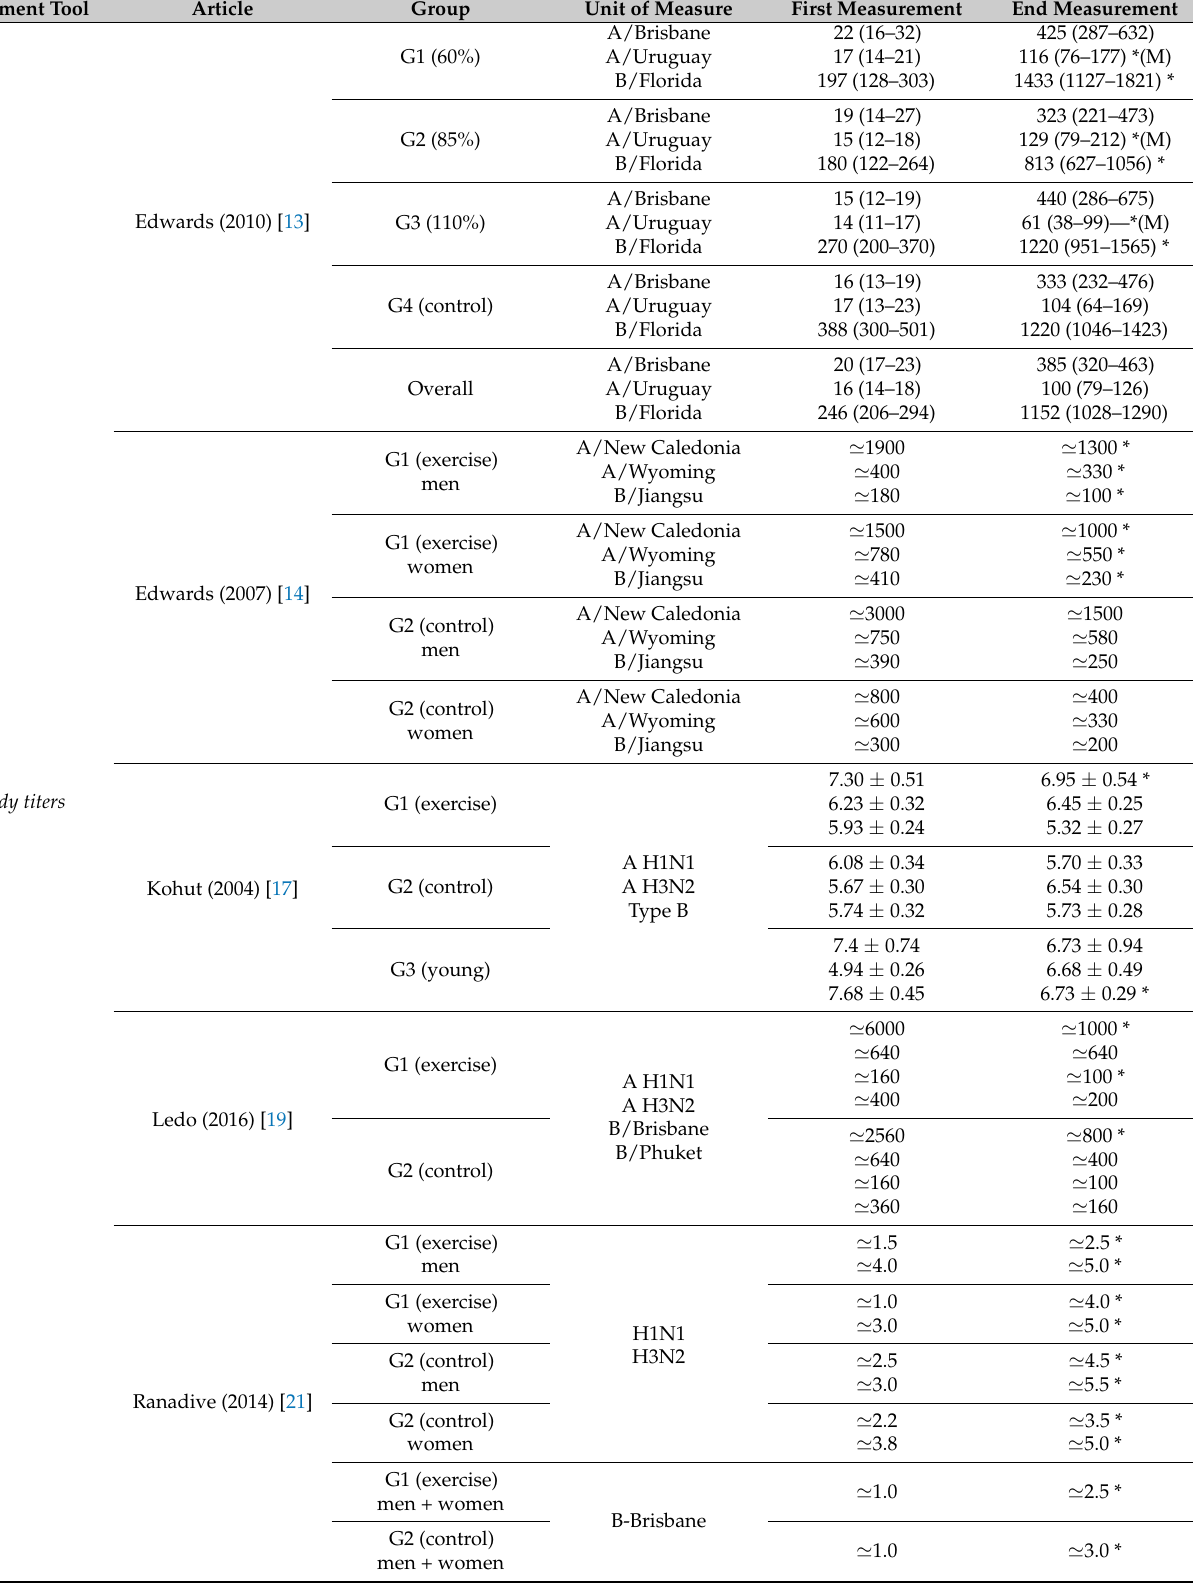
Table 3. Results of the hematic variables analyzed in the different studies included in this systematic